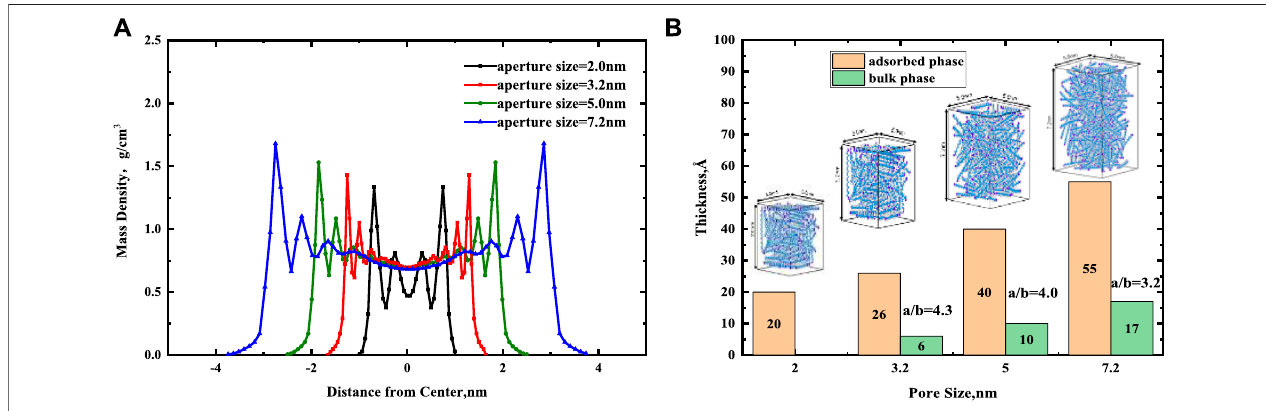
FIGURE6|(A) Effectofporesizeonthecontinuousmassdensitypro fi lesfornC19inthemixednanopores. (B) Thethicknessofadsorbedphaseandbulkphaseat different pore sizes.